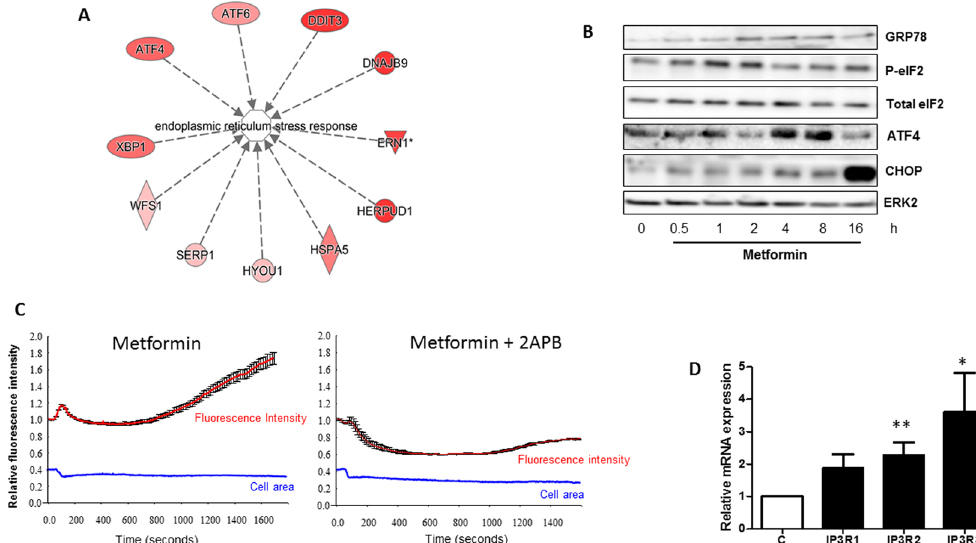
Figure 1. Metformin induces ER stress and calcium release from the ER. ( A ) List of genes related to the ER stress pathway and significantly upregulated in LNCaP cells treated with 5 mM metformin for 14 h. (B) Immunoblotting of LNCaP cells treated with 5 mM metformin for the indicated times by using antibodies directed against the indicated proteins implicated in ER stress response. The immunoblot is representative of three independent experiments. The blots represent ( C ) Relative fluorescence intensity of the Fluo-4AM probe, measured in LNCaP cells. 2-ABP (40 µ M) was added 15 min before the addition of 5 mM metformin at time 0. The cellular area was monitored during the experiment (blue line). At least 30 single cells were monitored for each condition. The graph represents the mean fluorescence intensity + / − sem. ( D ) Quantification of IP3R mRNA in LNCaP cells treated with metformin for 24 h. p < 0.05 ( * ); p < 0.01 ( **